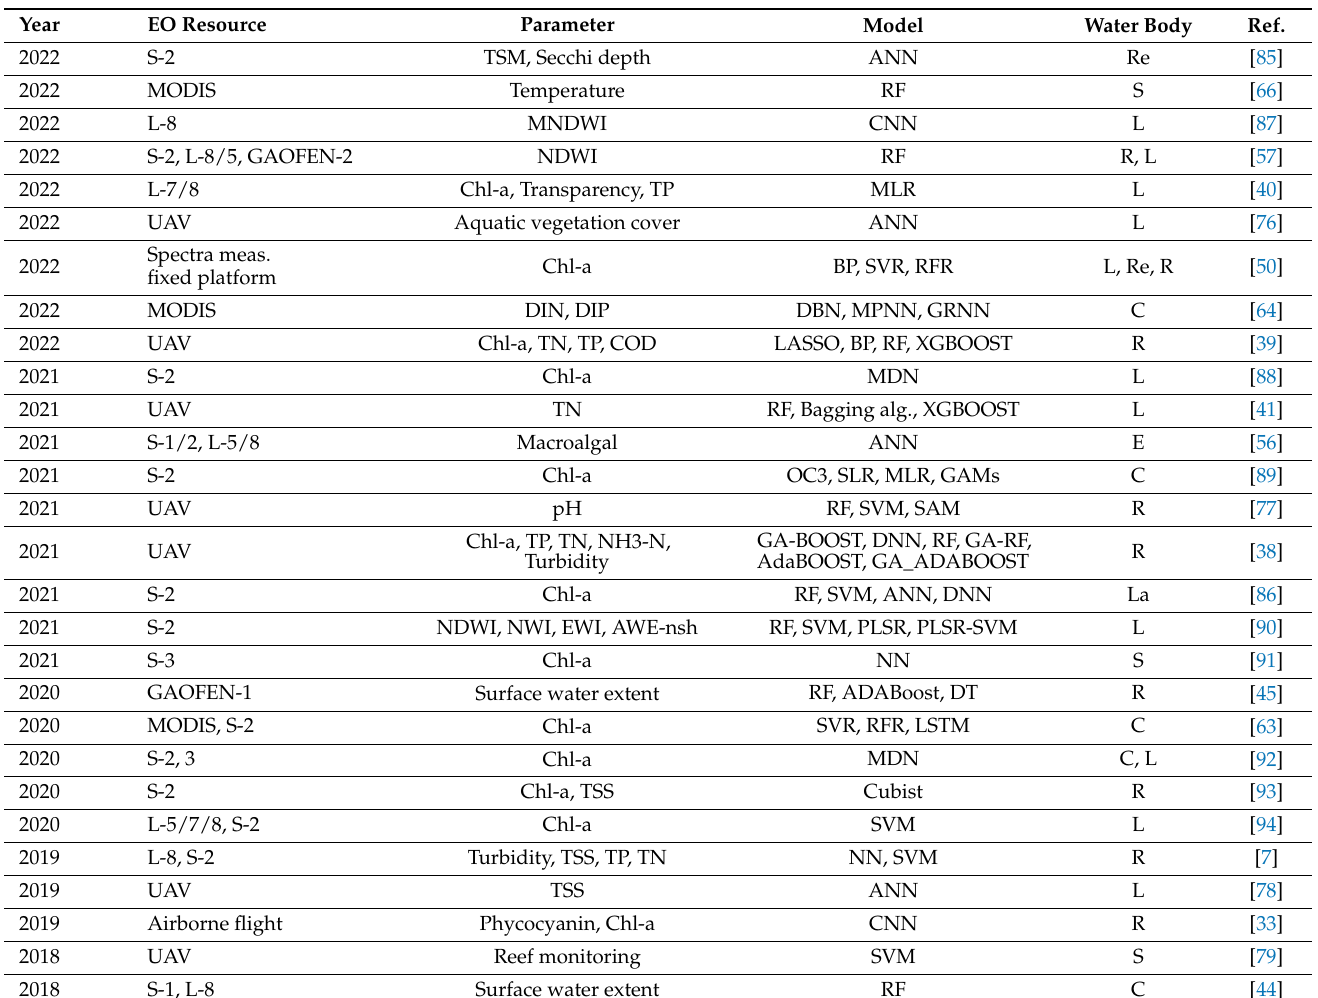
Table 3. A detailed presentation of the sensors, parameters, and models per water body type for the 28 examined studies related to modeling techniques (for EO resource column, S = Sentinel and L = Landsat, while for Water Body column, L = Lake, R = River, C = Coast, S = Sea, Re = Reservoir, La = Lagoon, E =